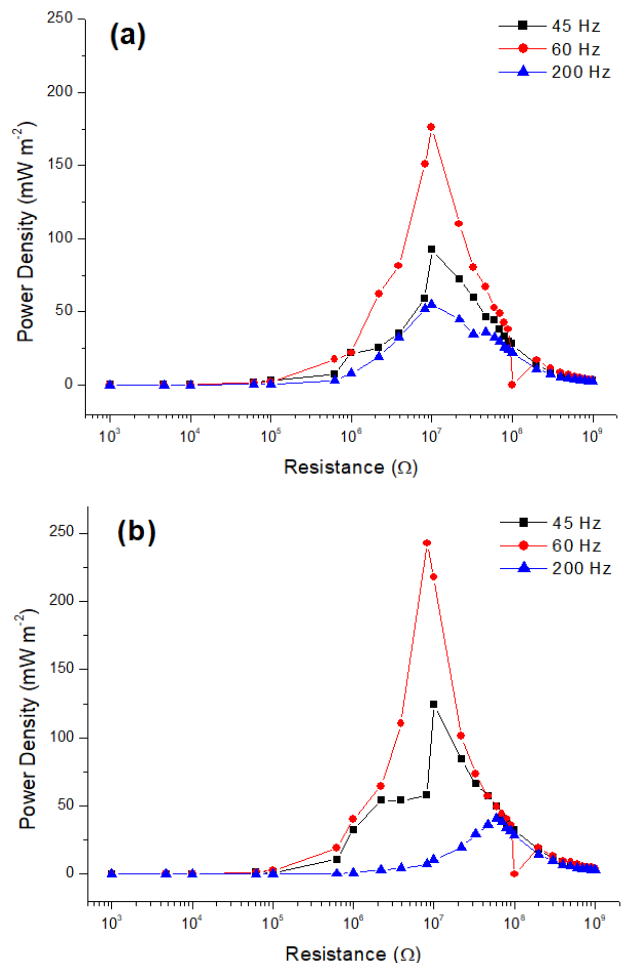
Figure 7. Power density versus resistance for TENGs assembled with different configurations: